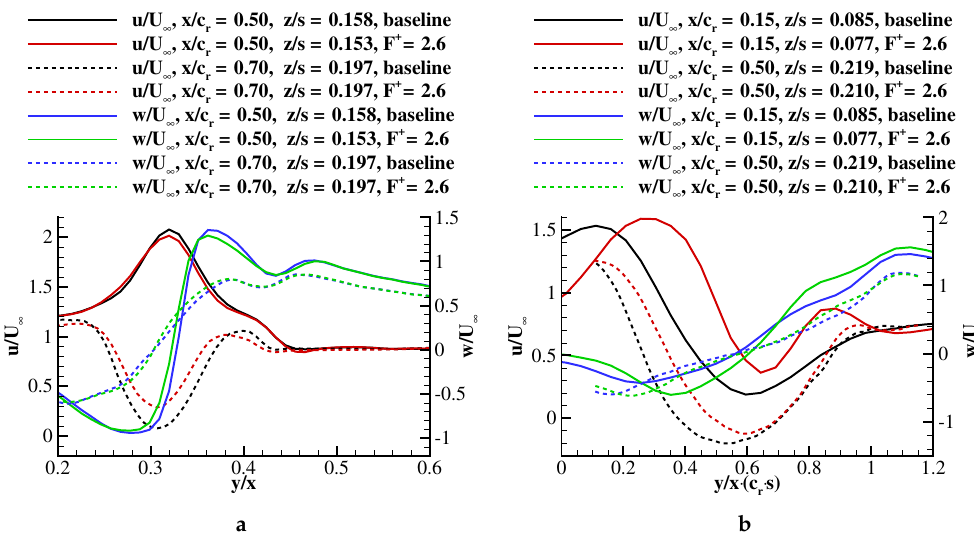
Figure 12. Axial and azimuthal relative velocity profiles at two chord stations (upstream: line, downstream: dashed line) across the vortex comparing baseline (red, black) with perturbed flow (green blue): ( a ) α = 23 ◦ ( x / c r = 0.50, 0.70) and ( b ) α = 35 ◦ ( x / c r = 0.15, 0.50).